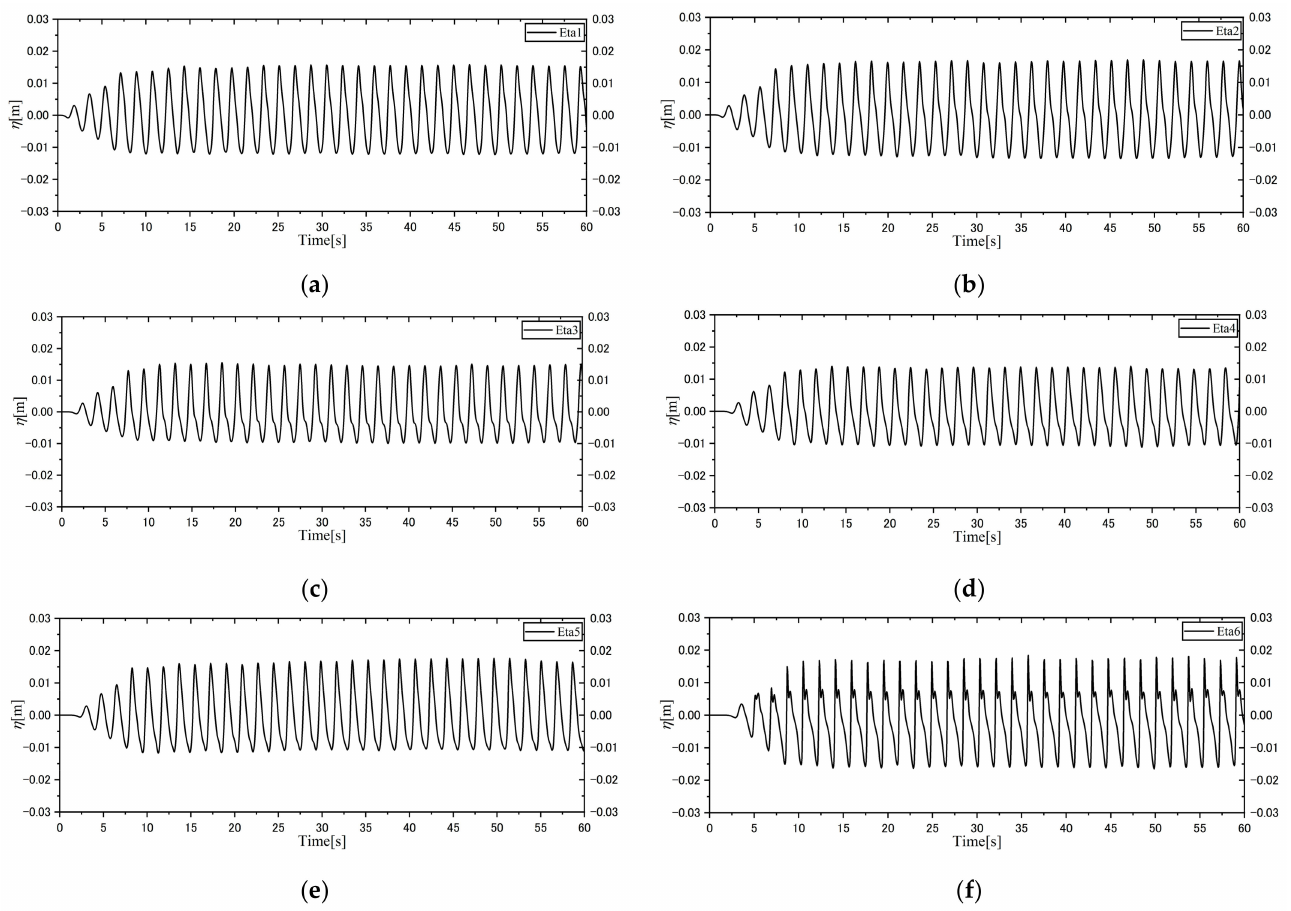
Figure 8. Water surface elevation profiles at the corresponding wave gauge positions in case 1 (T-1.80 s): ( a ) W1 ( r = 234 cm), ( b ) W2 ( r = 264 cm), ( c ) W3 ( r = 300 cm), ( d ) W4 ( r = 336 cm), ( e ) W5 ( r = 369 cm ) , and ( f ) W6 ( r = 405